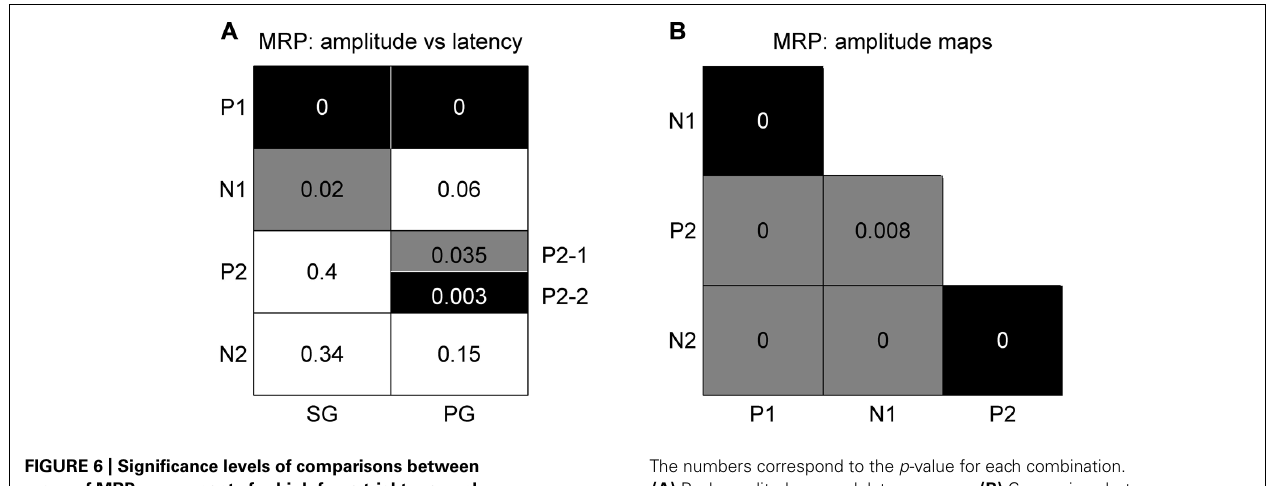
FIGURE 6 | Significance levels of comparisons between maps of MRP components for high force trial types only. Black: statistically significant ( p < 0.05) positive match; gray: statistically significant negative match; white: not significant.